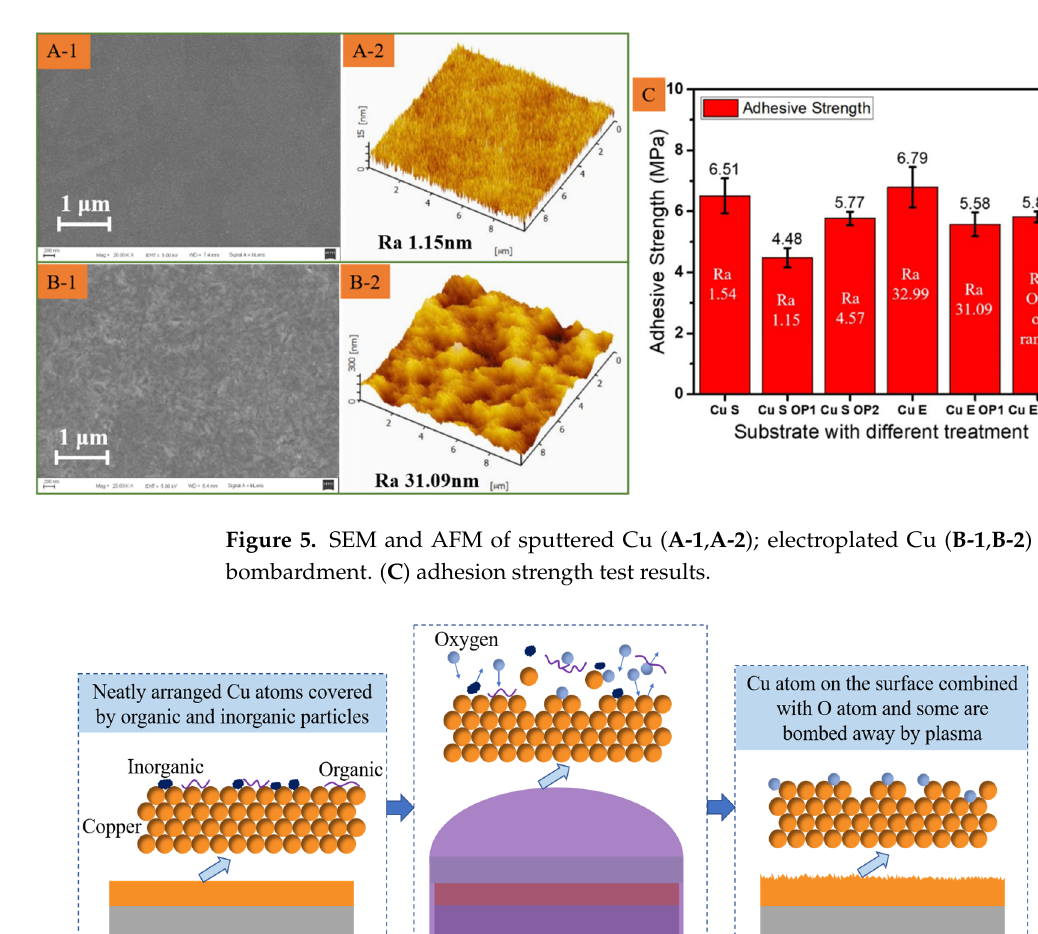
Figure 7. Surface topography of SU-8 with pushpin-like reinforce microstructure array ( A-1 ) before and ( A-2 ) after thrust test. ( B ) Surface topography of normal SU-8. ( C ) Adhesion strength. First, the pushpin-like nano/microstructure array can effectively improve the contact area between the polymer and the substrate. The bottom of the pushpin is the area of the original substrate, and the top is the surface area of the reinforced structure, given in Fig- ure 8. Through calculation, it can be seen that the surface area of the reinforced structure is larger than that of the planar structure, and the surface area obtained by the arc rotation with the cylinder center as the rotation axis and the radius r is added. Its expression is shown as Equation (2).